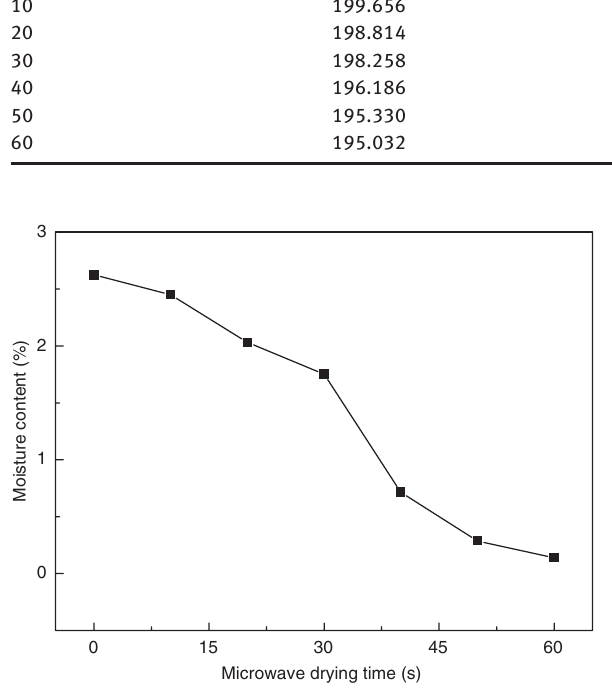
Figure 9: Effects of microwave drying time on the moisture content of high titanium slag (microwave power: 700 W; bed depth: 10 mm; sample mass: 200